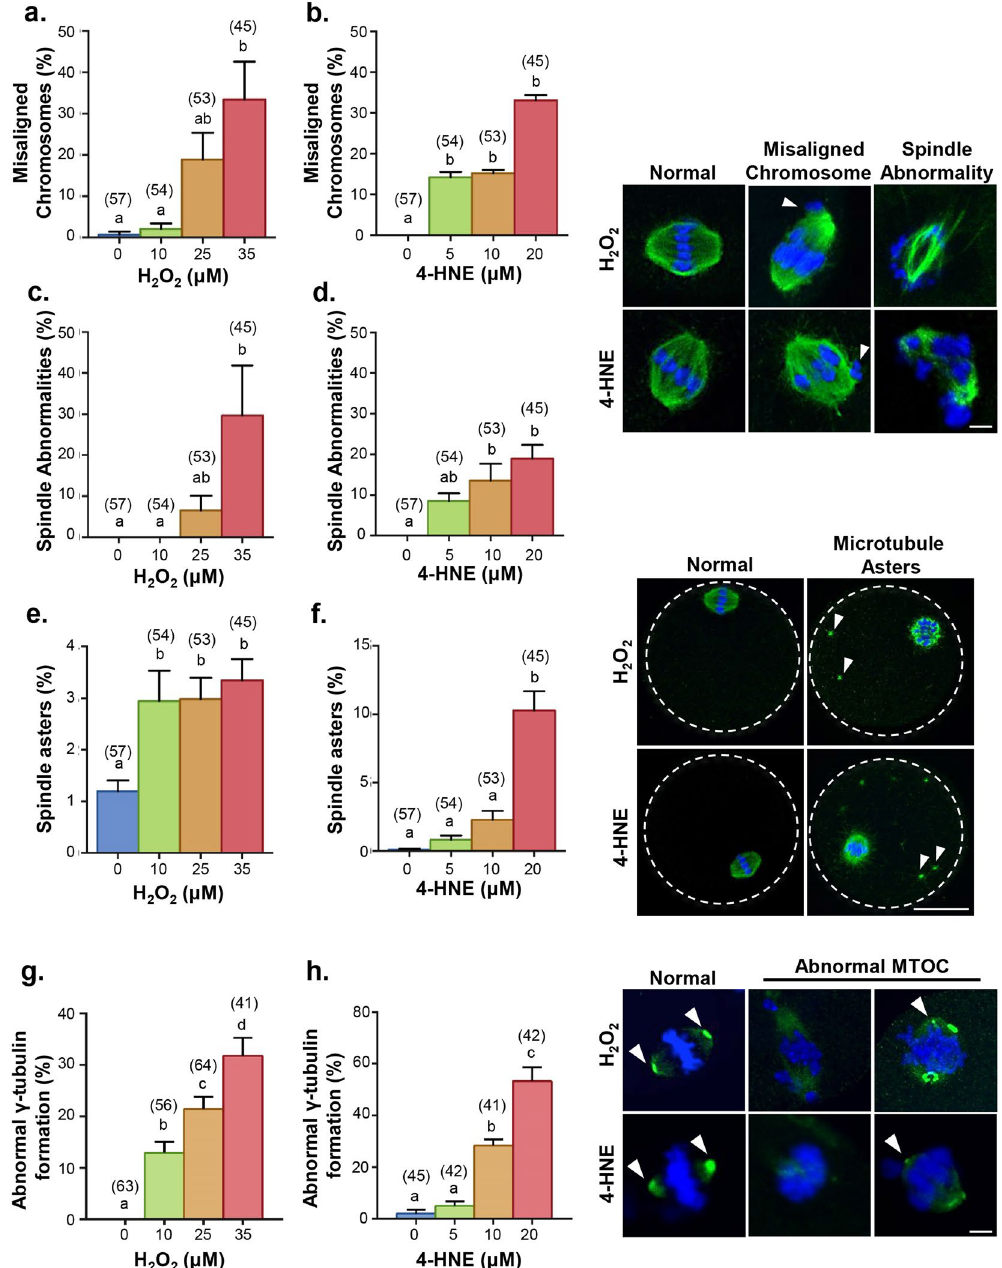
Figure 4. Acute exposure to H 2 O 2 and 4-HNE at prophase I arrest led to a reduction in MII spindle integrity. GV oocytes were treated with either with 10, 25 and 35 μ M H 2 O 2 for 1 h or 5, 10 and 20 μ M 4-HNE for 2 h. Following treatment, oocytes underwent IVM for fixation at MII to observe spindle and chromosome integrity using α -tubulin immunofluorescence (green) and the nuclear stain Hoechst (blue). ( a ) An increase in chromosome misalignment was observed at 35 µ M H 2 O 2 ( p ≤ 0.0044) and ( b ) 5, 10 and 20 µ M 4-HNE treatment ( p ≤ 0.0001). White arrows point to misaligned chromosome(s). ( c ) Additionally, an increase in spindle anomalies was also documented at concentrations of 35 µ M H 2 O 2 ( p ≤ 0.0131) and ( d ) 10 and 20 µ M 4-HNE ( p ≤ 0.0388). Scale bar = 5 μ m. ( e ) An increase in the number of microtubule asters was also identified at 10, 25 and 35 μ M H 2 O 2 ( p ≤ 0.0188) and ( f ) 20 μ M 4-HNE ( p ≤ 0.0001). Scale bar = 20 μ m. ( g ) Lastly, a dose- dependent increase in abnormal formation of the MTOC was identified at 10, 25 and 35 μ M H 2 O 2 ( p ≤ 0.038) and ( h ) 10 and 20 µ M of 4-HNE ( p ≤ 0.0089) using γ -tubulin immunofluorescence (green). Nuclei were counterstained with Hoechst (blue). Scale bar = 5 μ m. Error bars represent SEM. Immunocytochemistry was performed with three biological replicates with each replicate containing between 10–30 oocytes pooled from a minimum of three